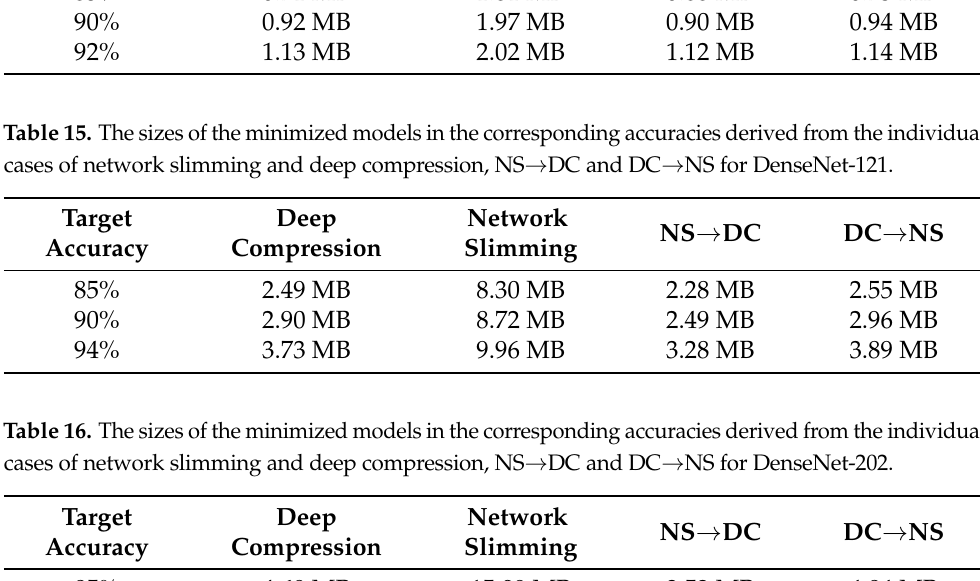
Table 14. The sizes of the minimized models in the corresponding accuracies derived from the individual cases of network slimming and deep compression, NS